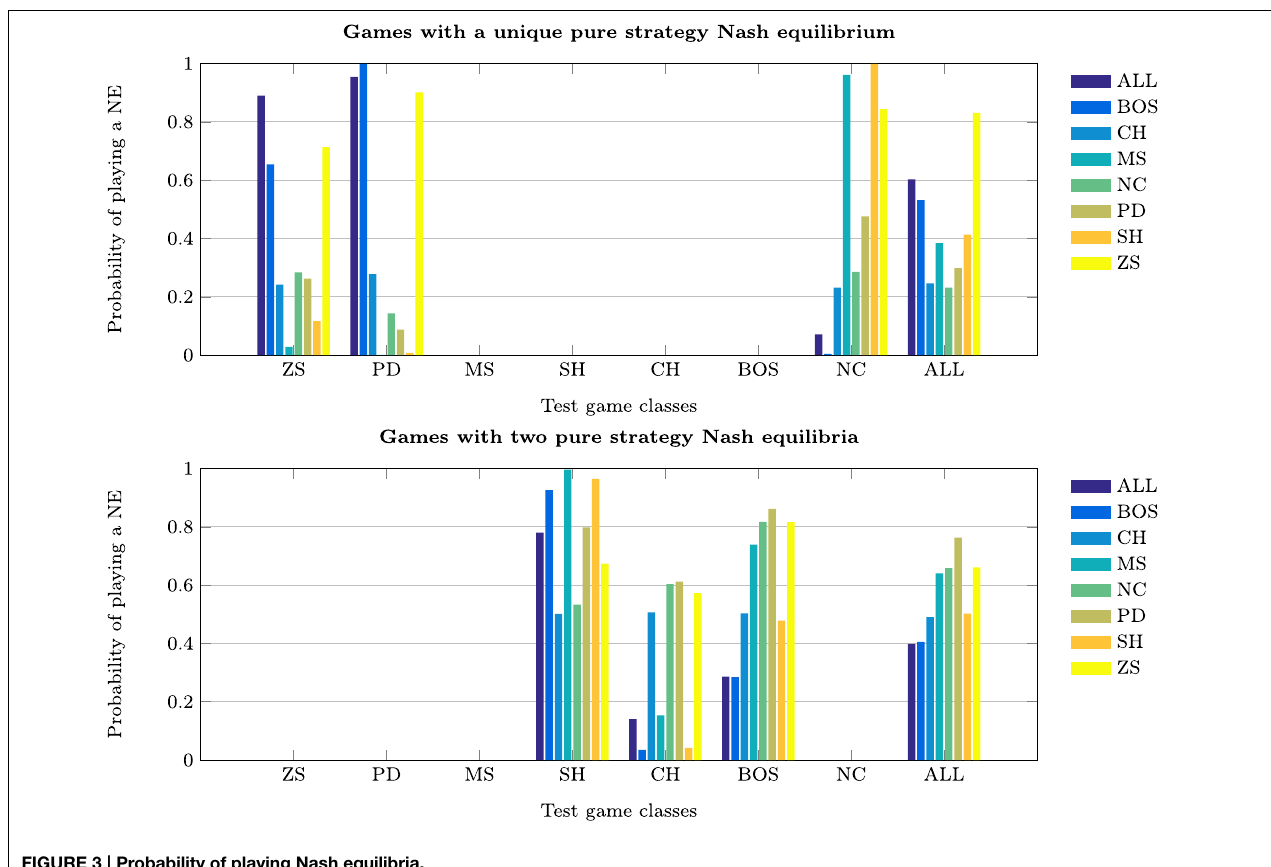
FIGURE 3 | Probability of playing Nash equilibria.